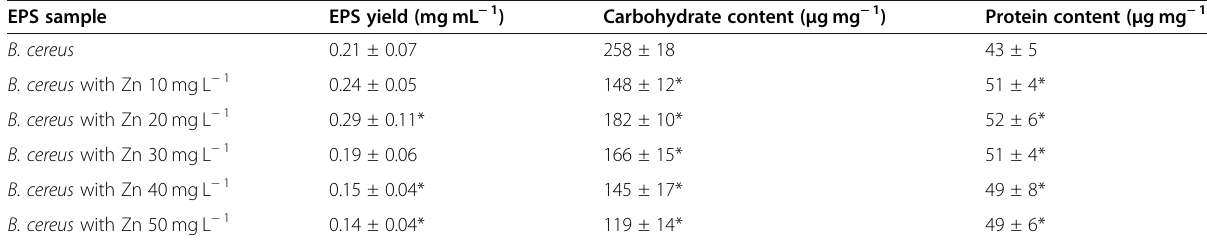
Table 2 The characteristics of EPS under various Zn stress (10, 20, 30, 40, 50 mg L − 1 )